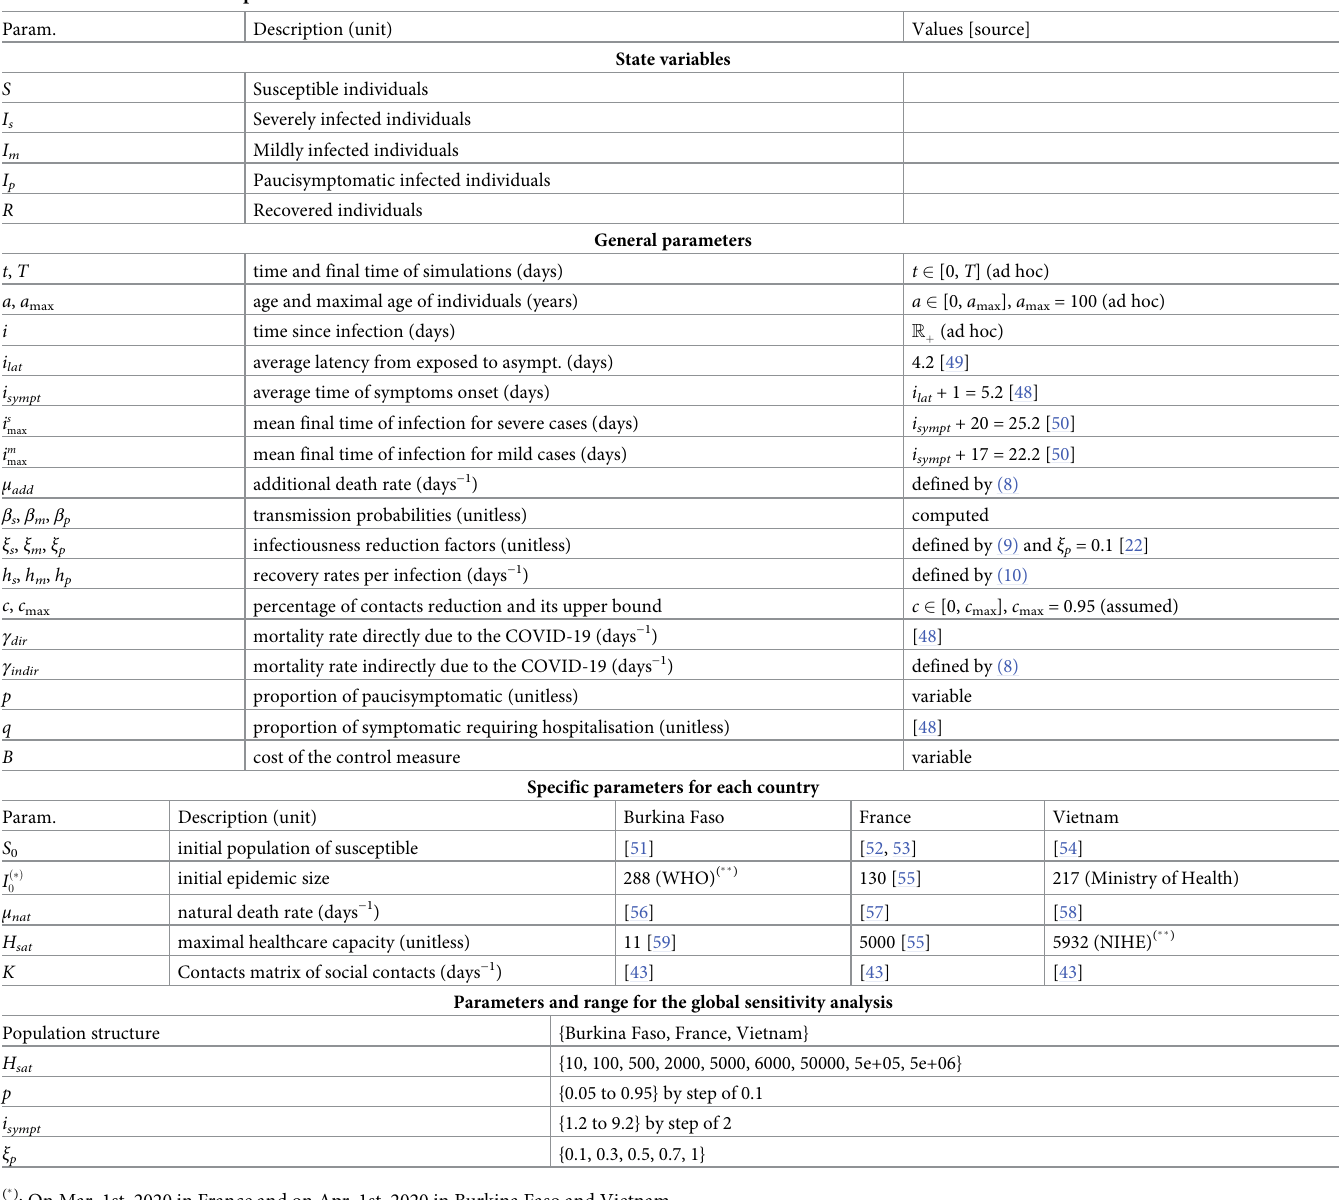
Table 1. Model variables and parameters. We show the notations used and indicate references for the numerical values used.